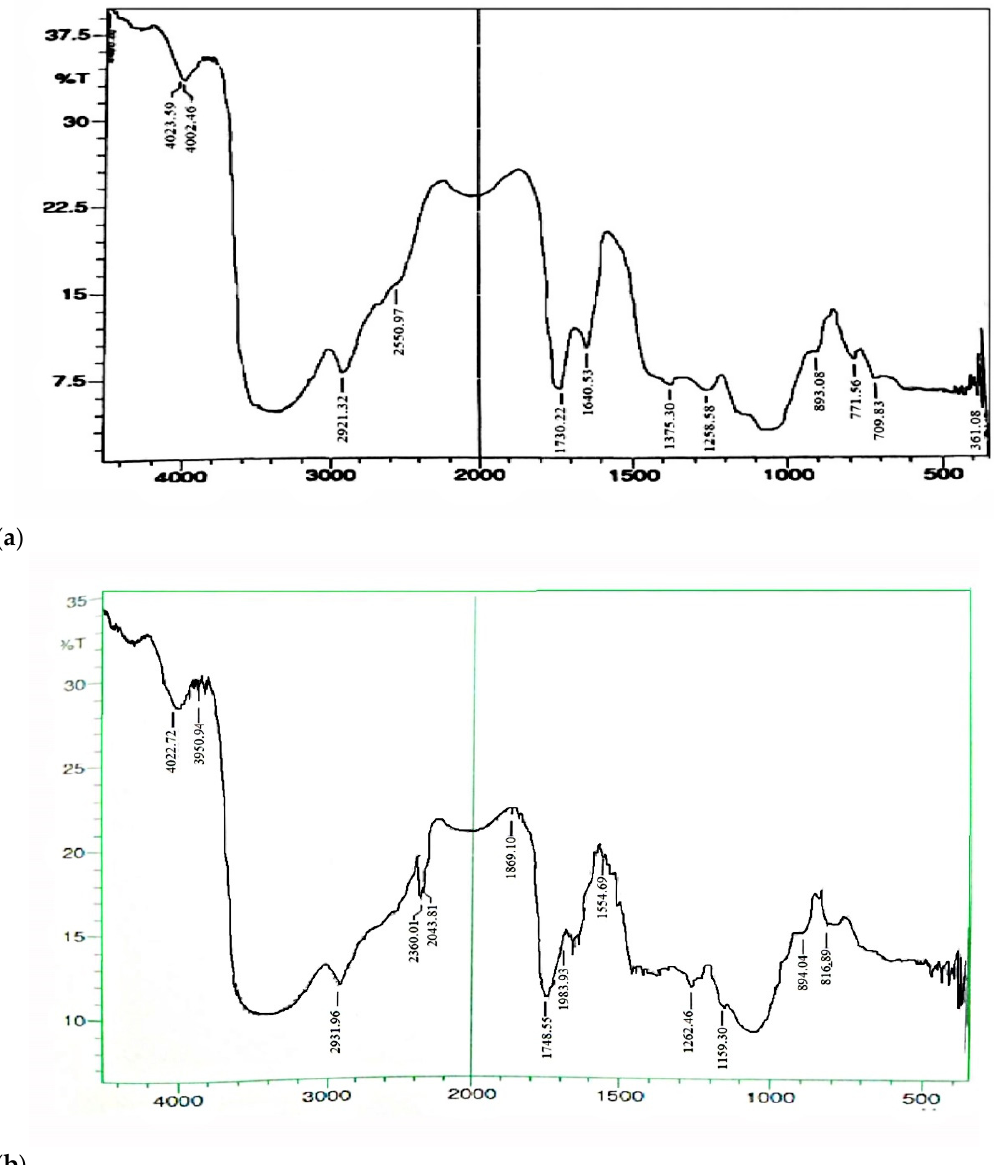
Figure 2. FT-IR spectrum of ( a ) Plain mixture and ( b )TRM of gum acacia and karaya.